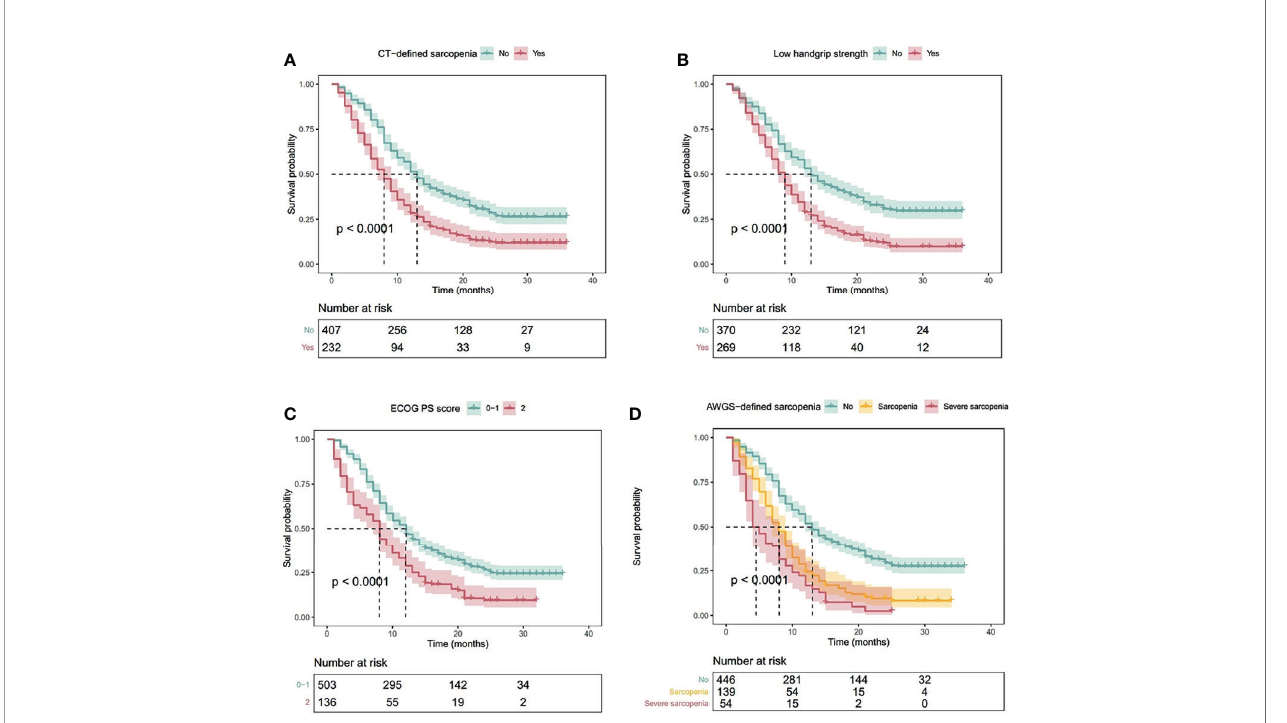
FIGURE 3 | Kaplan – Meier Curves Illustrating Overall Survival in Patients with (A) CT-De fi ned Sarcopenia, (B) Handgrip Weakness, (C) Low Physical Performance (ECOG PS Score ≥ 2), and (D) AWGS-De fi ned Sarcopenia or Severe Sarcopenia. P values indicate the results of the log-rank test. Shadowed areas indicate 95% con fi dence intervals. AWGS, Asian Working Group for Sarcopenia; CT, computed tomography; ECOG PS: Eastern Cooperative Oncology Group performance